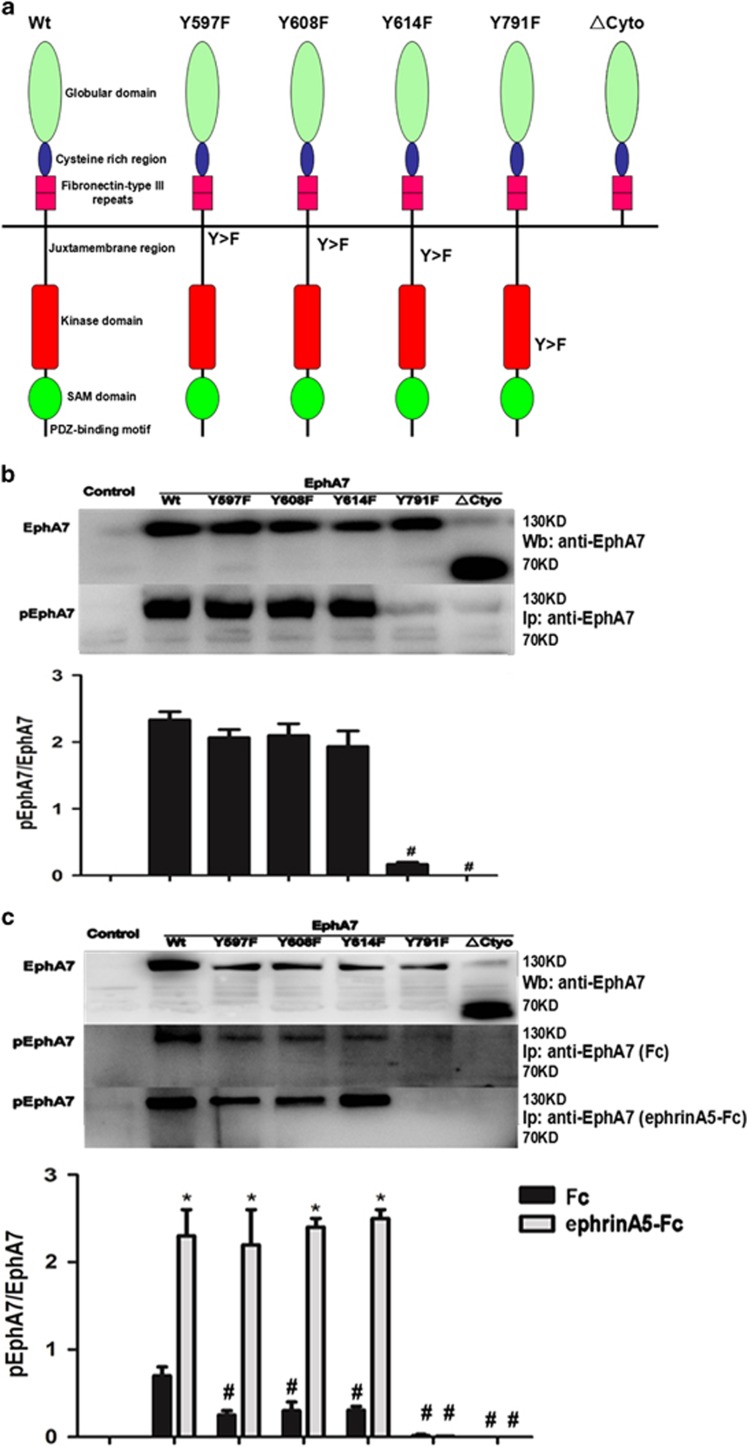
Tyrosine 791 of EphA7 is the major phosphorylation site for the EphA7 receptor in PCa cells. (a) A diagram of EphA7 receptor structure and mutants. (b) The expression and phosphorylation of EphA7 in DU145 cells stably overexpressing either WT EphA7 receptor or EphA7 mutants. (c) The expression and phosphorylation of EphA7 in PC-3 cells stably overexpressing either EphA7(WT) receptor or EphA7 mutants. Cells were serum-deprived for 24 h and then stimulated with 1.0 μg/ml of ephrinA5 ligand or Fc for 15 min. After cell lysis, EphA7 was immunoprecipitated with anti-EphA7 antibody and then divided into two aliquots for immunoblotting with anti-EphA7 antibody and anti-phosphotyrosine (4G10) antibody. Data are shown as the mean±S.D.#P<0.05, versus the respective WT EphA7 group, *P<0.05, versus the respective control group